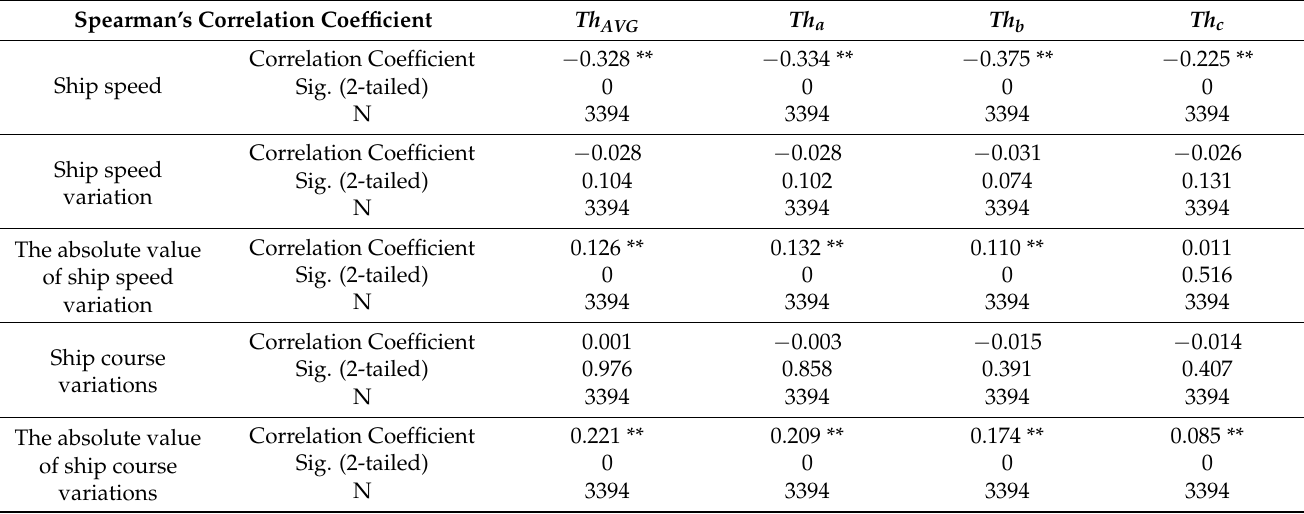
Table 5. The correlation coefficient between sea ice thickness and ship